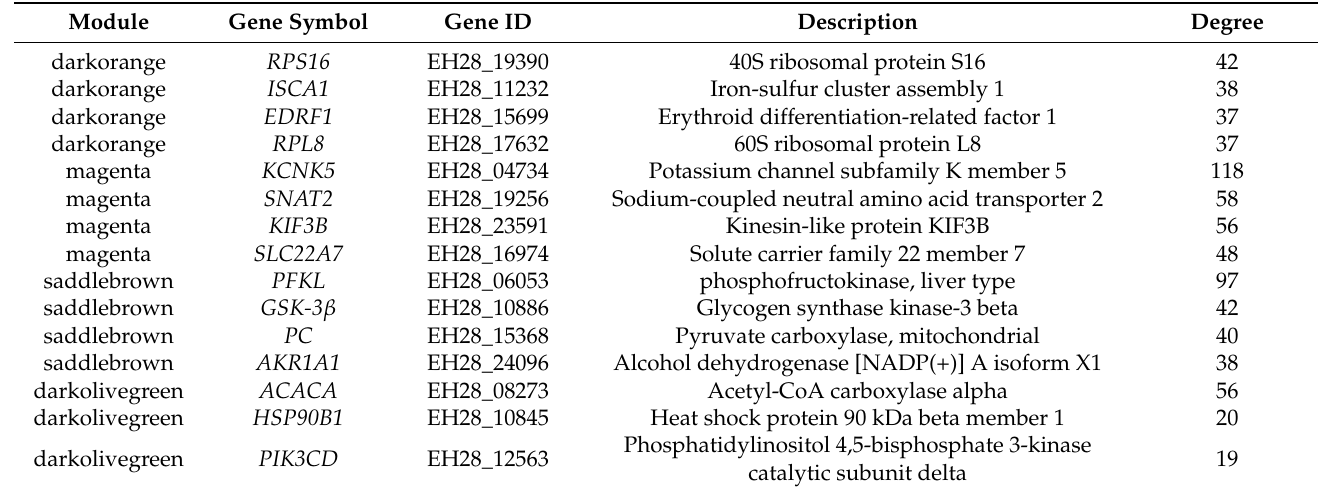
Figure 6. The local co-expression network analysis of darkorange ( A ) magenta ( B ) saddlebrown ( C ), and darkolivegreen ( D ) modules. The size and color of each node circle is positively correlated with the number of interacting genes. Table 1. Functional annotation of the hub genes of the target